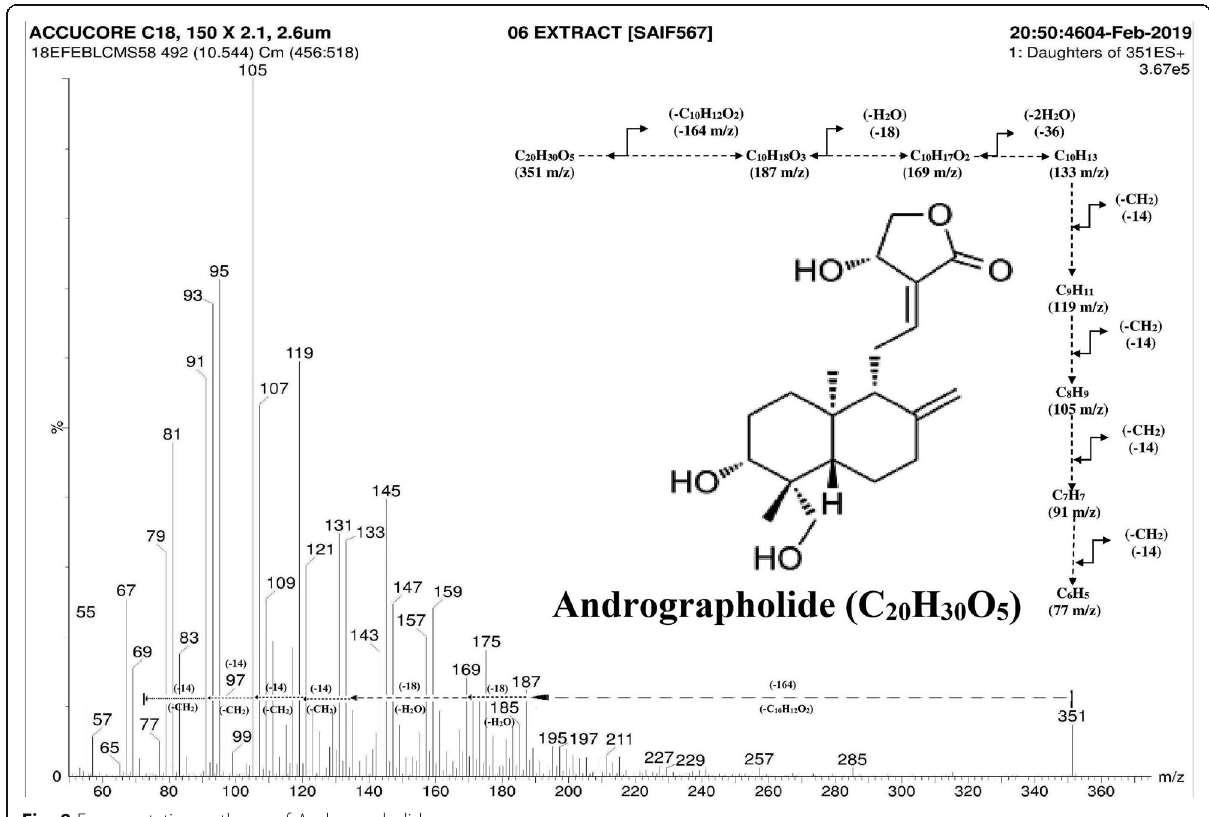
Fig. 8 Fragmentation pathway of